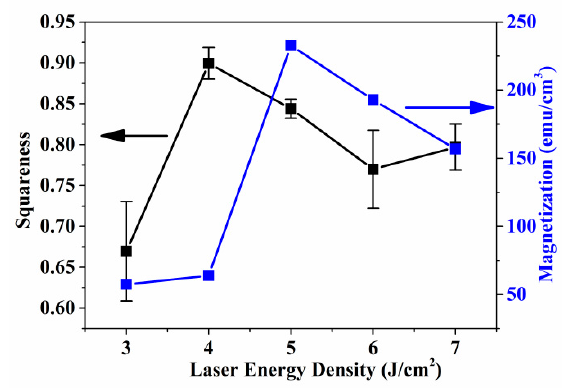
Figure 6. The squareness and saturation magnetization (M s ) of FePt/MgO nanocomposite films.